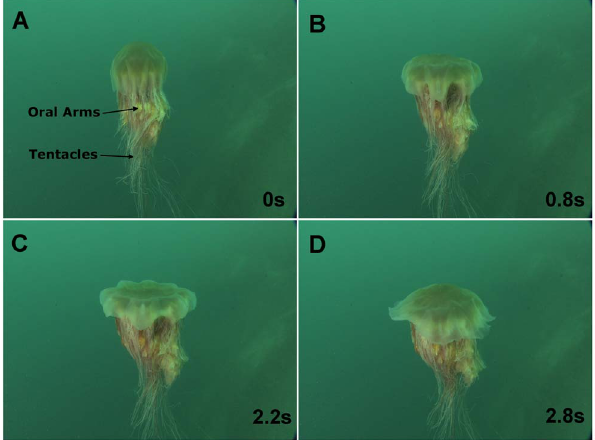
Fig. 2. Cyanea Capillata wimming sequence. Swimming sequence of a large C. capillata in the Atlantic Ocean off the Norwegian shore. The animal is shown in the (A) fully contracted, (B) relaxing, (C) fully relaxed and (D) contracting states. The swimming cycle shown is the first of two processed